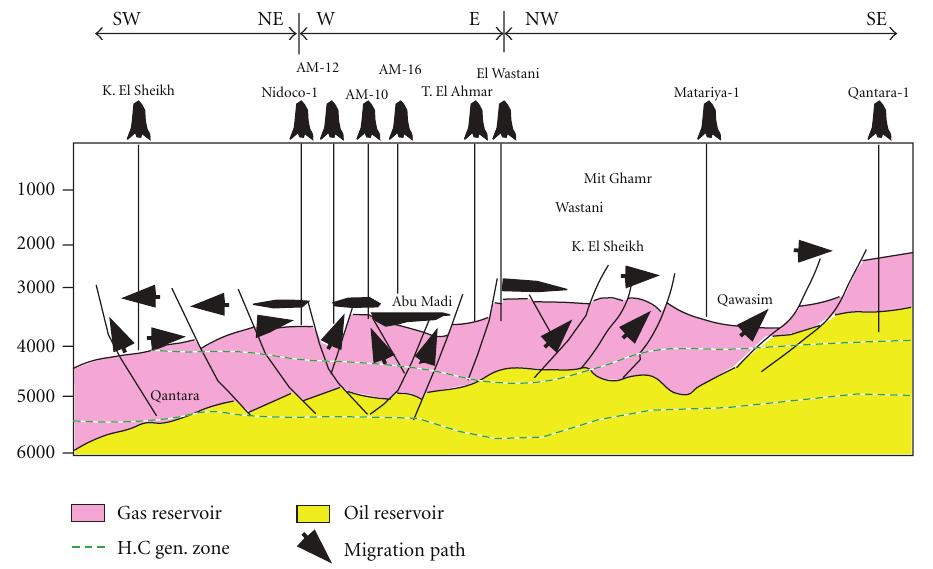
Figure 14: Hydrocarbon reservoirs and migration paths through the Nile Delta (modified after